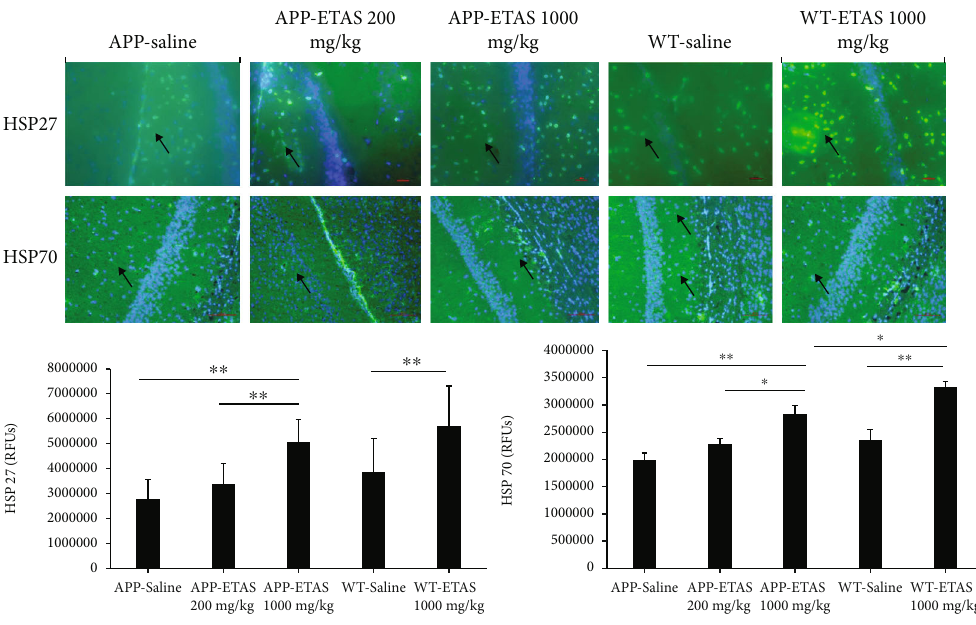
Figure 3: Quanti fi cation of heat shock protein (HSP27) and HSP70 in the hippocampus of APP-overexpressed mice treated with ETAS (200mg/kg and 1000mg/kg) and WT mice treated with ETAS (1000mg/kg) for 1 month, respectively; RFUs: relative fl uorescence units; green represents HSP27/70 expression, and blue represents DAPI. Arrows represent fl uorescent green staining, indicating positive expression. Magni fi cation is represented × 200. HSP27: ∗∗ p < 0 : 01 APP-ETAS (1000mg/kg) vs. APP-ETAS (200mg/kg) and APP saline- treated mice; ∗∗ p < 0 : 01 WT-ETAS (1000mg/kg) vs. WT saline-treated mice; RFUs: relative fl uorescence units. Four mice per group and four sections per mouse were used. HSP70: ∗ p < 0 : 05 APP-ETAS (1000mg/kg) vs. APP-ETAS (200mg/kg); ∗∗ p < 0 : 01 APP-ETAS (1000mg/kg) vs. APP saline-treated mice; ∗∗ p < 0 : 01 WT-ETAS (1000mg/kg) vs. WT saline-treated mice. RFUs: relative fl uorescence units. Four mice per group and four sections per mouse were